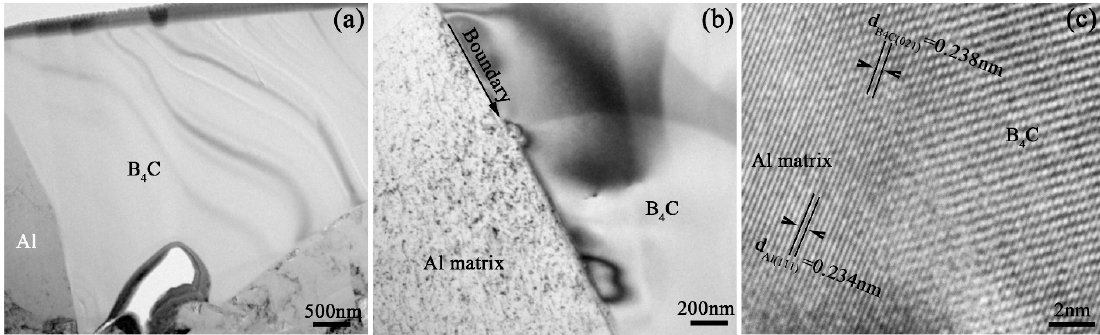
Figure 6. ( a ) Bright field TEM image of Al-30%B 4 C MMCs; ( b ) High magnification of crystal boundary between Al matrix and B 4 C particle; ( c ) high resolution TEM (HRTEM) image.